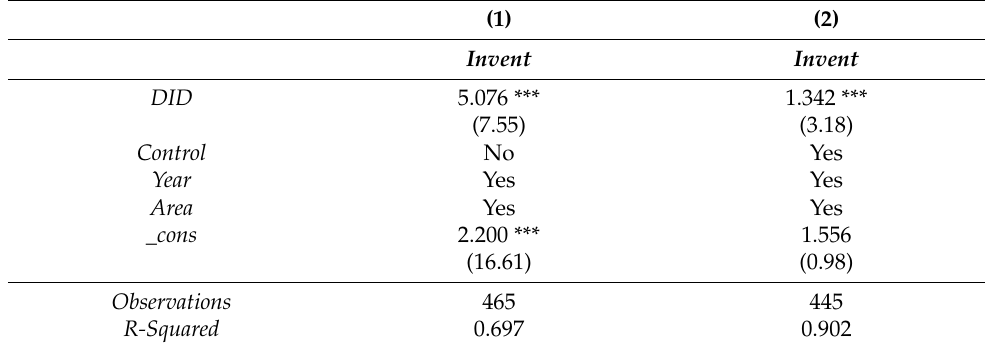
Table 2. Baseline regression results.